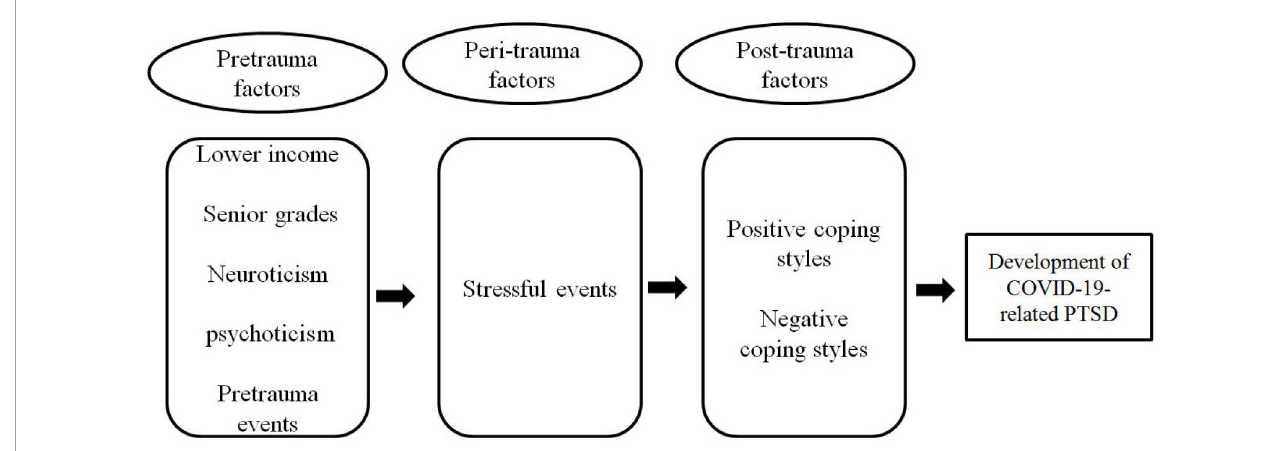
FIGURE2 Factors related to COVID-19-associated PTSD symptoms among Chinese college